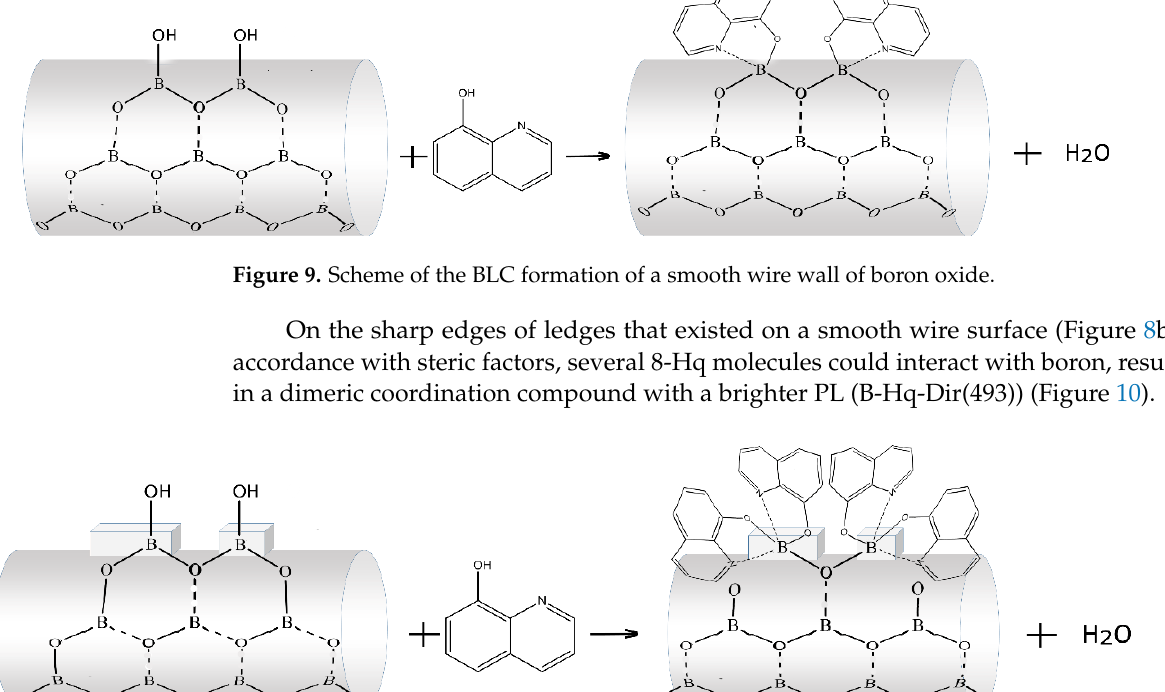
Figure 8. Photo of boron oxide wires ( a ) and SEM image of BLC ( b ) and silica aerogel ( c ).